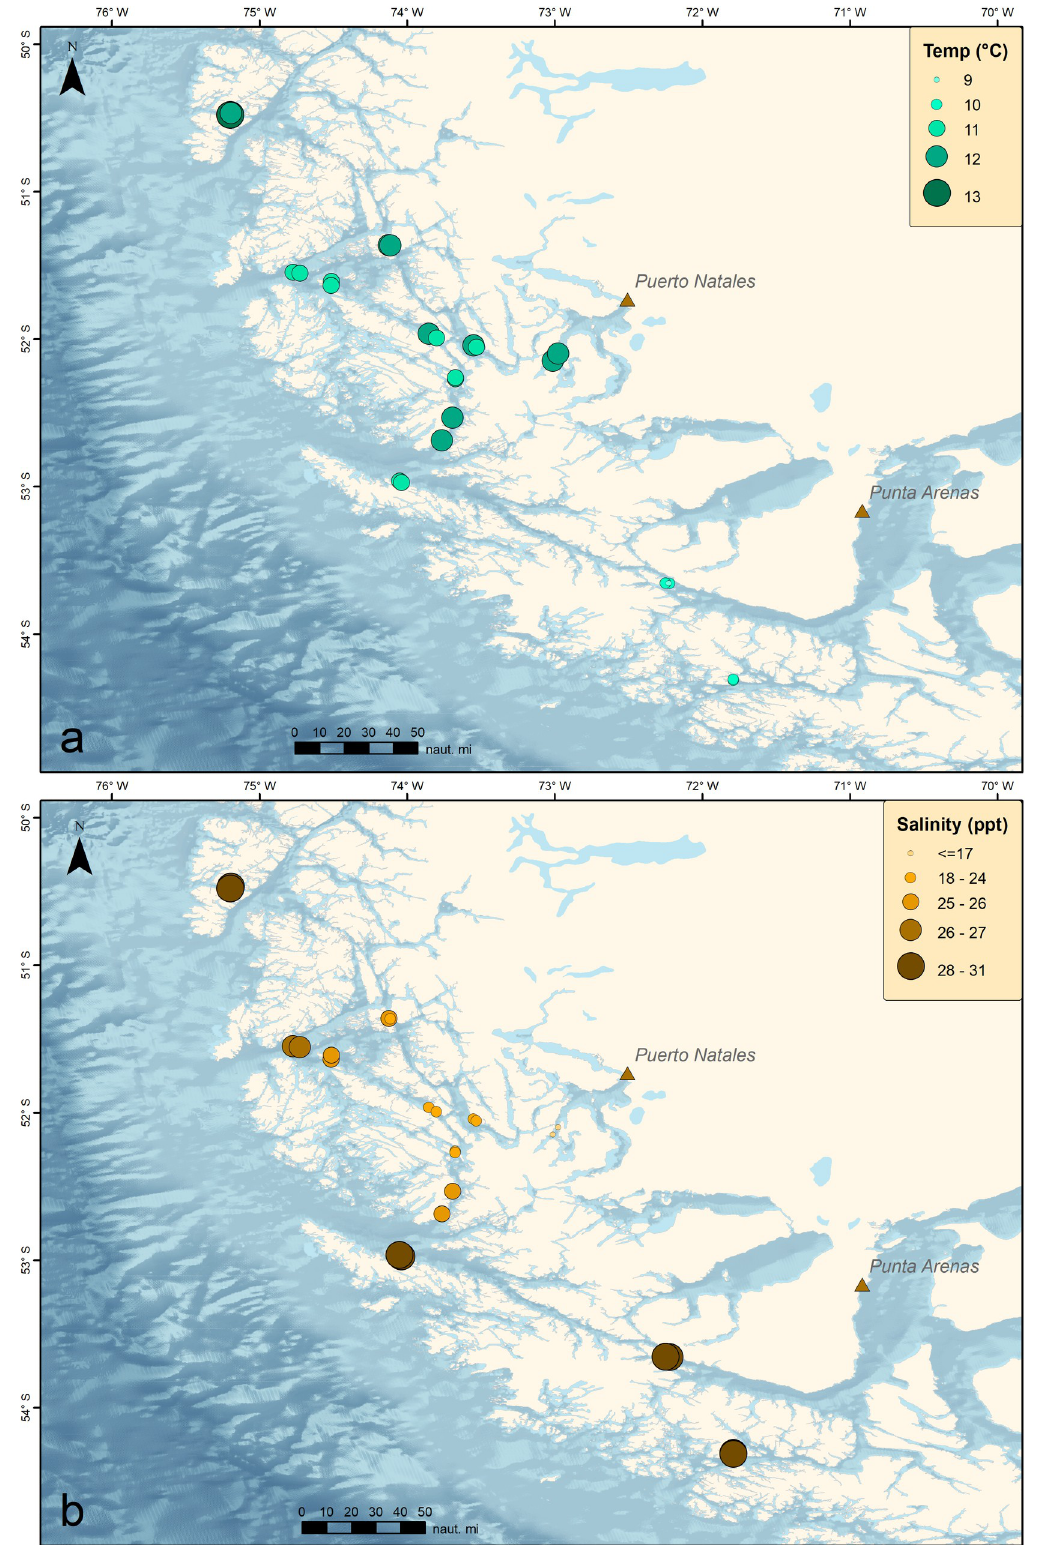
Fig 2. (A) Temperature (˚C) and (B) Salinity (ppt) at sampling stations in the Kawe´sqar National Reserve.